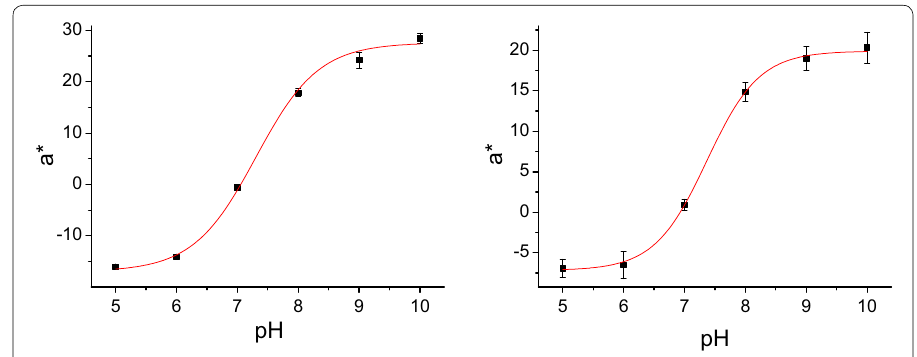
Fig. 4 Measurement range of the strongly coloured indicator washcloth IW1 ( left ) and the weakly coloured indicator washcloth IW4 ( right ) with n =